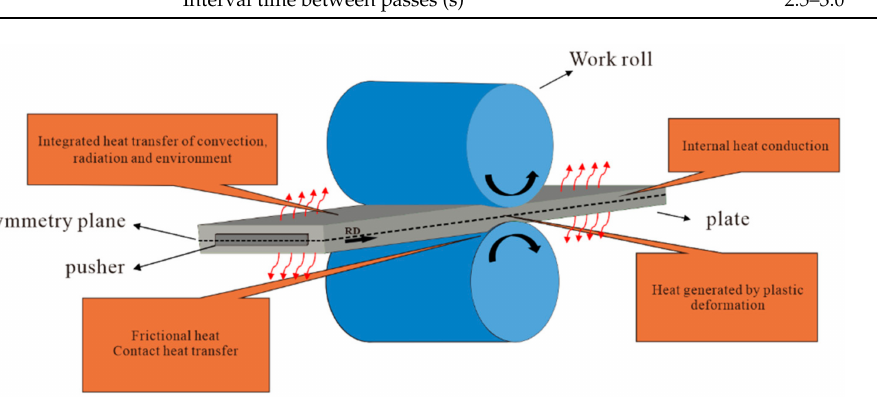
Figure 2. Schematic diagram of finite element simulation and boundary conditions of molybdenum plate rolling